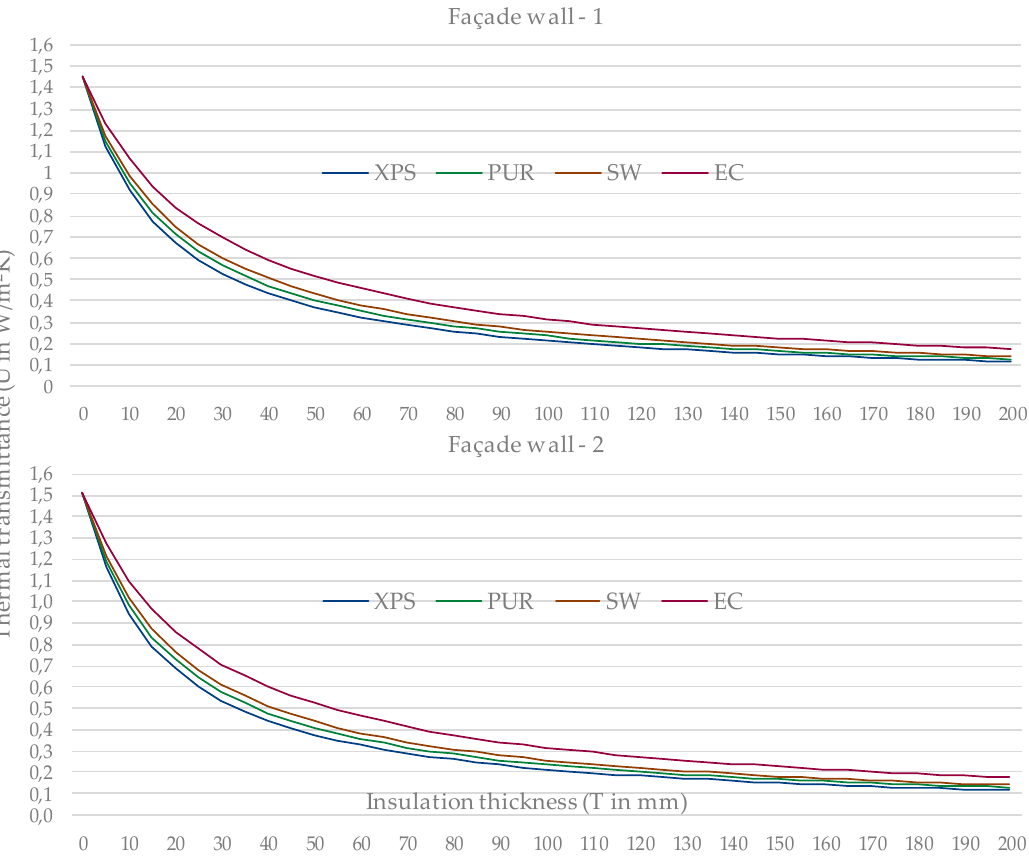
Figure A9. Thermal transmittance (U-value) according to insulation thickness, for façade walls.